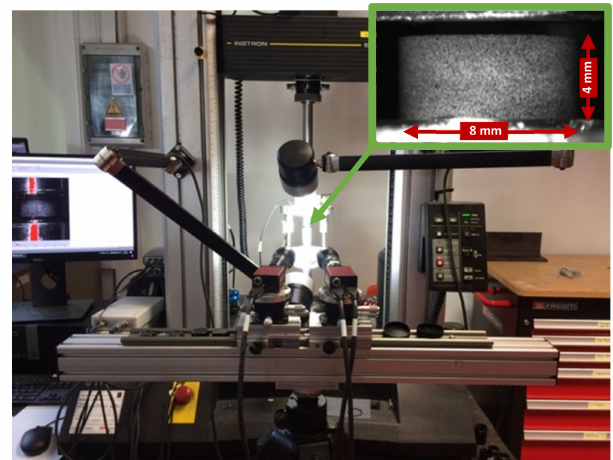
Figure 3. Quasi-static compression setup with a detail of the speckled sample (top right).